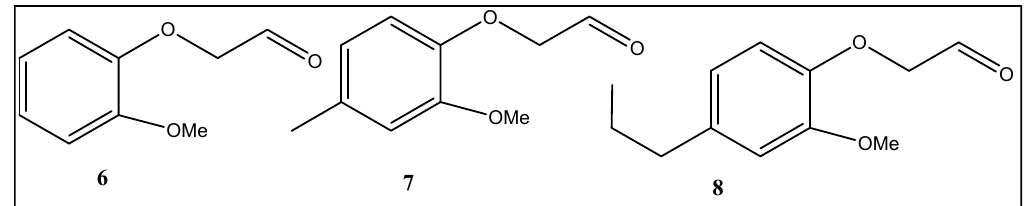
Figure 6. Bendioxepinone and analog compounds.